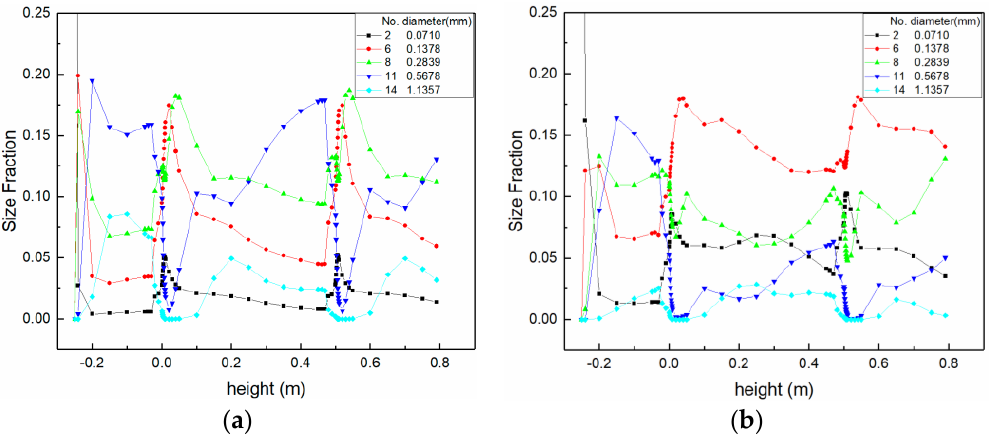
Figure 10. Size fraction for each group of bubbles: ( a ) Case 1, ( b ) Case 4.